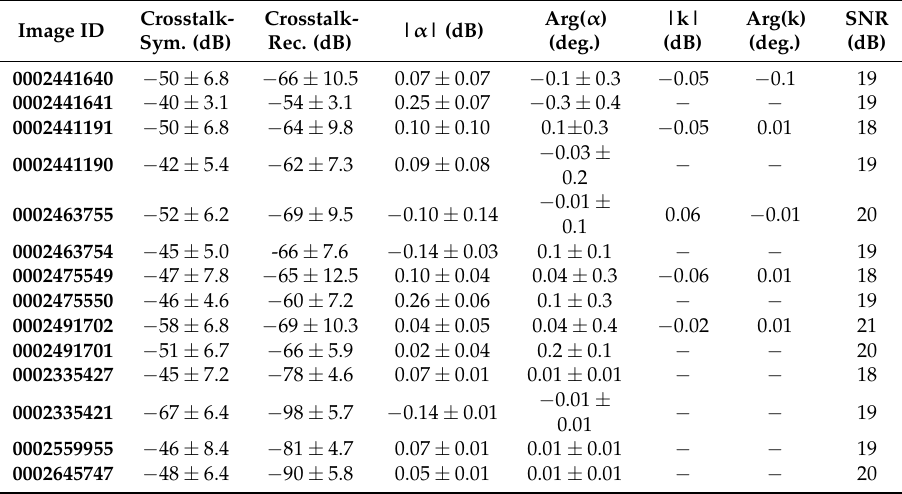
Table 4. Polarization residual errors after